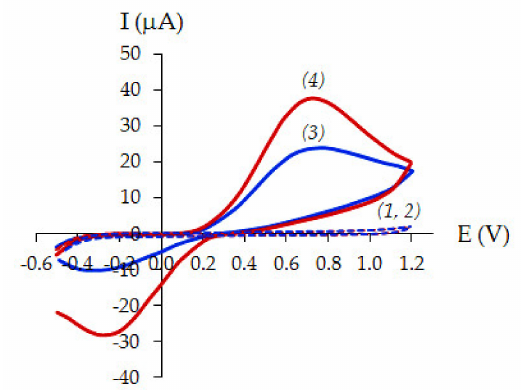
Figure 6. Cyclic voltammograms of 1 mM K 4 [Fe(CN) 6 ] on ( 3 ) FCVE and ( 4 ) TrX100 / FCVE and ( 1, 2 ) in a supporting 0.1 M KCl solution. Potential scan rate: 0.05 Vs − 1 .